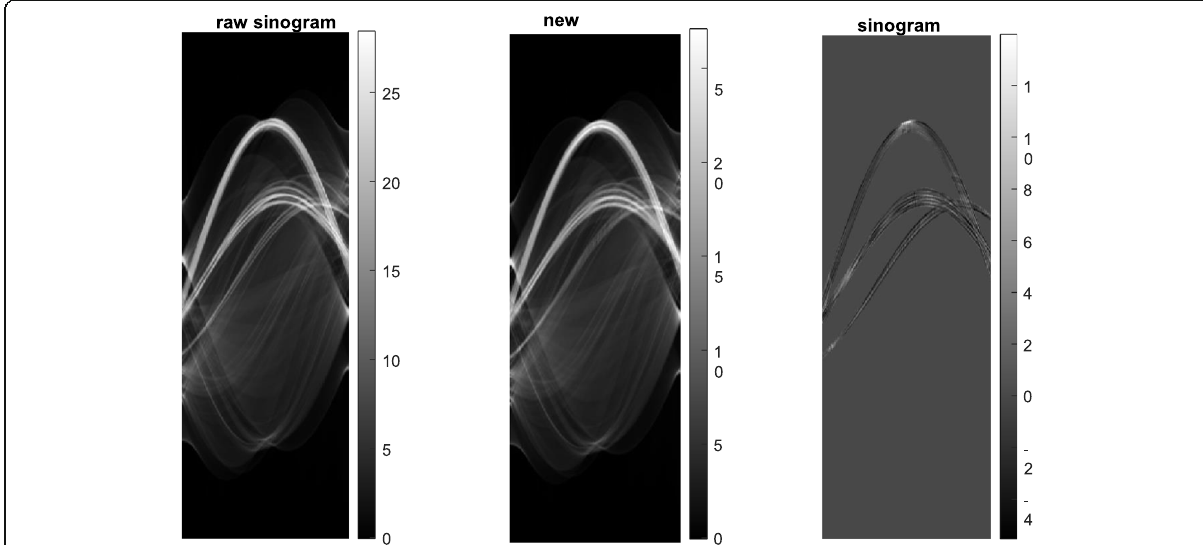
Fig. 6 Sinograms for airport bag #5. Left: the raw sinogram; Middle: the processed sinogram using the proposed algorithm; Right: the difference between the processed sinogram and the raw